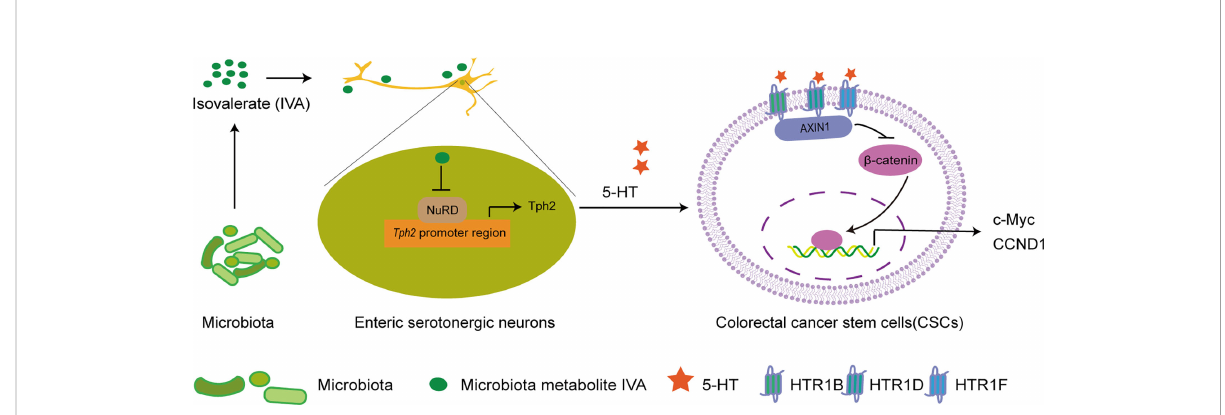
FIGURE 1 IVA stimulates 5-HT production in enteric serotonergic neurons to drive colorectal CSC self-renewal and tumorigenesis via 5-HT – Wnt axis. (A) Microbiota metabolite IVA inhibits the enrichment of NuRD complex onto Tph2 promoter to initiate Tph2 expression, leading to the production of 5-HT in enteric serotonergic neurons. By engaging with the receptors HTR1B, HTR1D, and HTR1F on colorectal CSCs, 5-HT promotes the interaction between AXIN1 and HTR1B/1D/1F, thus promoting the stability of b -catenin, activating the Wnt/ b -catenin signaling pathway, and enhancing the expression of Wnt/ b -catenin signaling target genes such as c-MYC and CCND1, leading to the self-renewal of colorectal CSCs and colorectal tumorigenesis. IVA, isovalerate; CSC, cancer stem